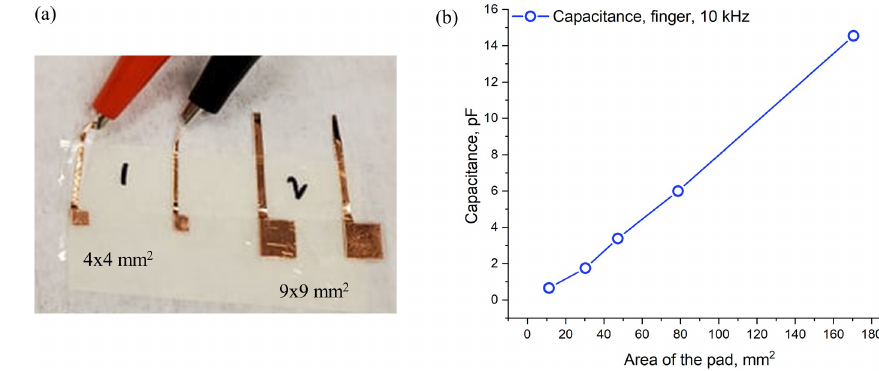
Figure 9. (a) Picture of different sizes of metal pads covered with plastic and (b) capacitance vs. area of the pads.